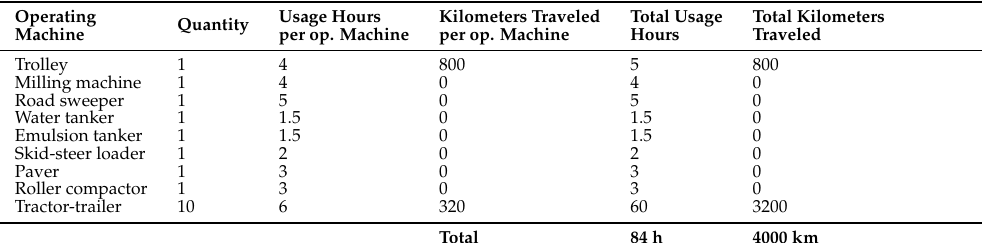
Table 5. Considered operating machines for phases A4 and A5 (cycle of transport and laying of asphalt on site) and estimate of the average duration of use and kilometers